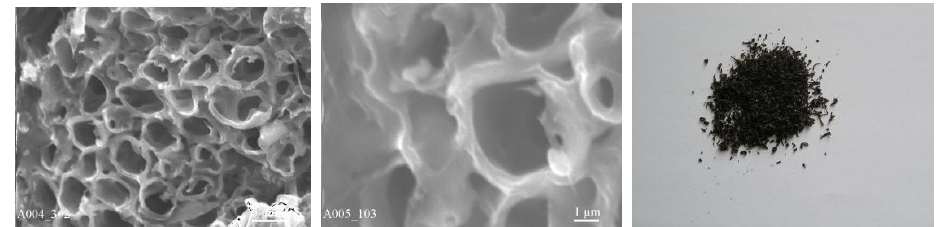
Colloids Interfaces 2019 , 3 , x FOR PEER REVIEW